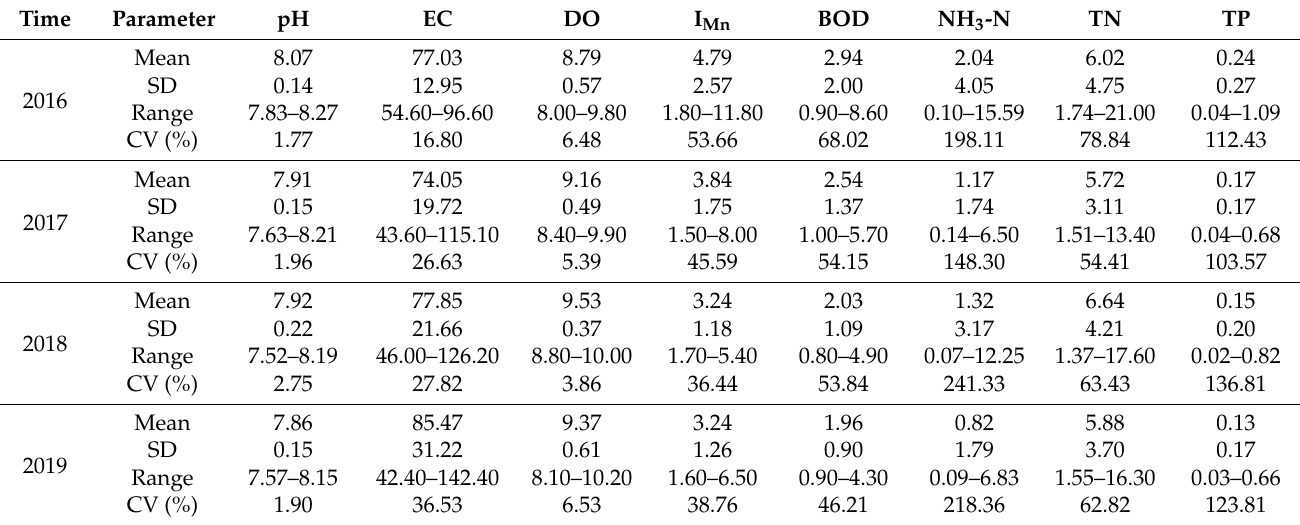
Table 2. Descriptive statistics of water quality indicators of the study